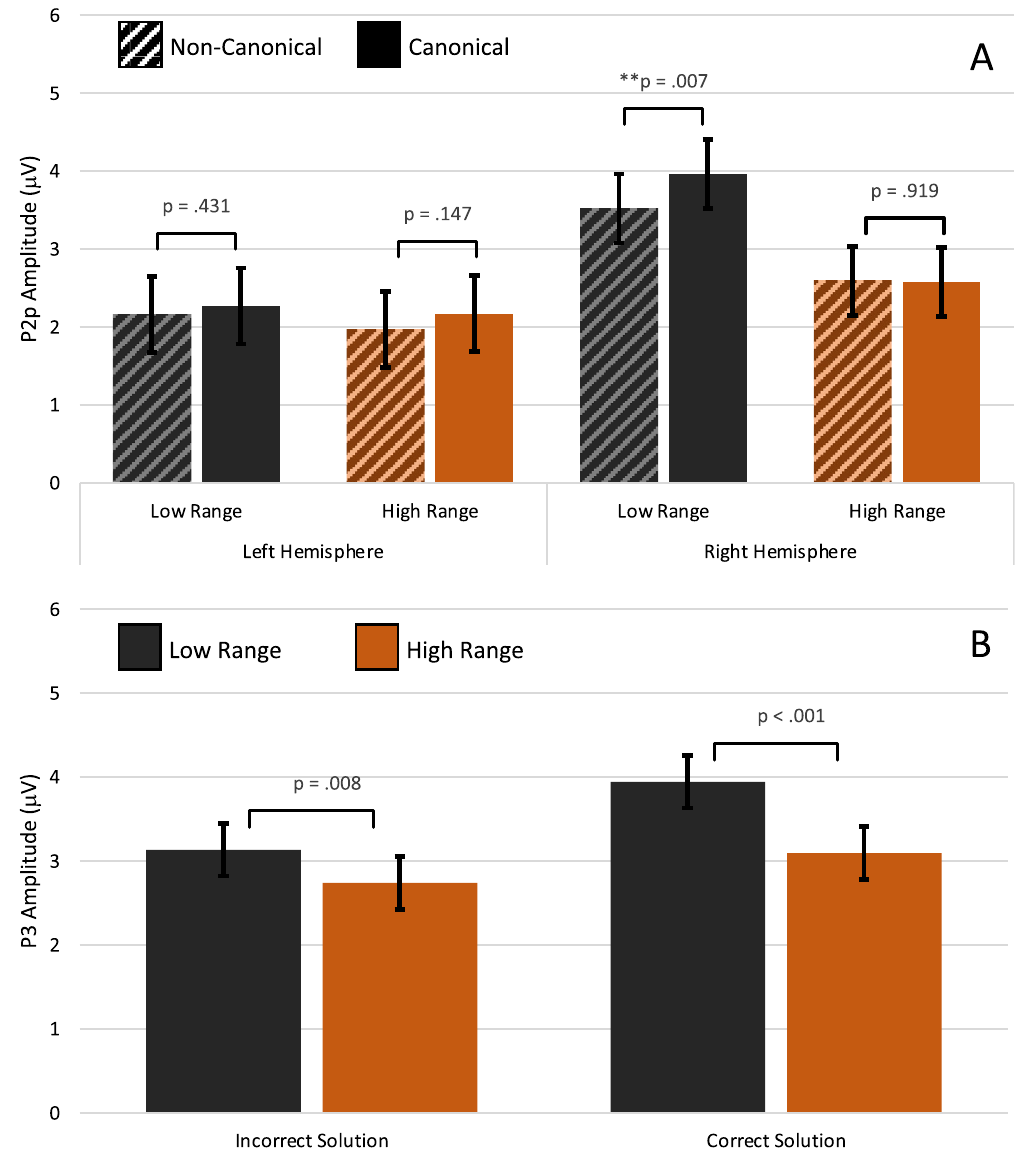
Figure 4. Top: Mean P2p amplitude (averaged across the 220–310 ms time window) at left and right hemisphere parietal (P3 and P4) electrodes in the four Canonicity-Range conditions: Canonical-Low, Non- Canonical-Low, Canonical-High, Non-Canonical-High. The figure shows the three-way interaction between Canonicity, Range and Hemisphere with a statistically significant canonicity effect on P2p amplitude occurring only in response to finger-number configurations showing small numerosities 2–4 above the right parietal hemisphere. Bottom: Mean P3 amplitude averaged across CPz and Cz electrodes in the four Solution-Range categories: Incorrect-Low, Correct-Low, Incorrect-High, Correct-High, showing the Solution × Range interaction with a larger numerical range effect on P3 amplitude (enhanced activation in response to hands showing small numbers 2–4) on trials with correct compared to incorrect sum